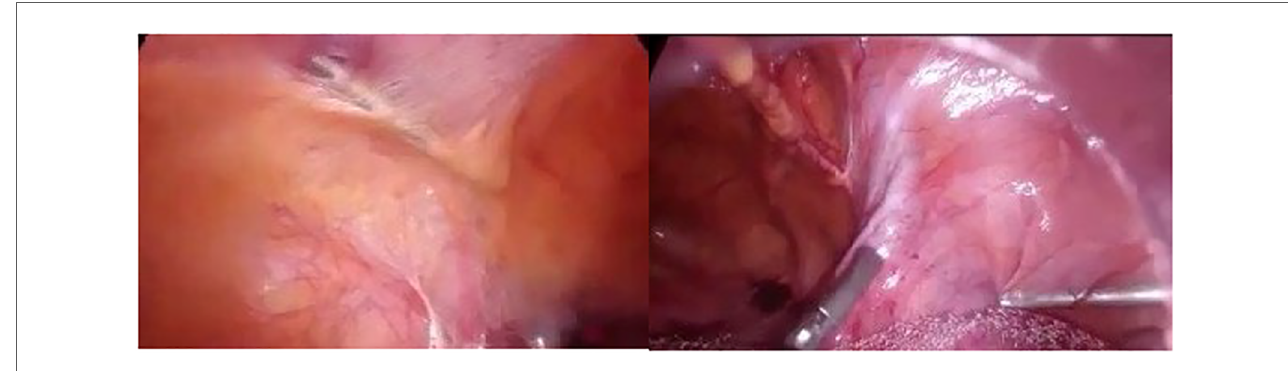
FIGURE 2 Reaching the mesh arms with the subperitoneal from the modi fi ed port site of the laparoscopic